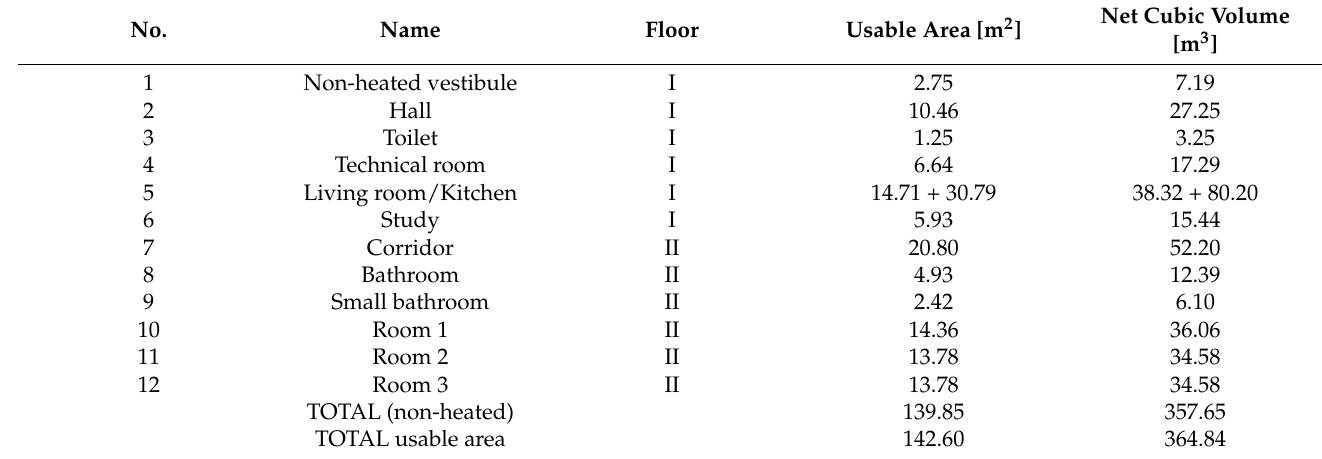
Table 6. List of rooms in the selected model B2/B3. Calculations in accordance with PN-ISO 9836:1997. Source: own study.